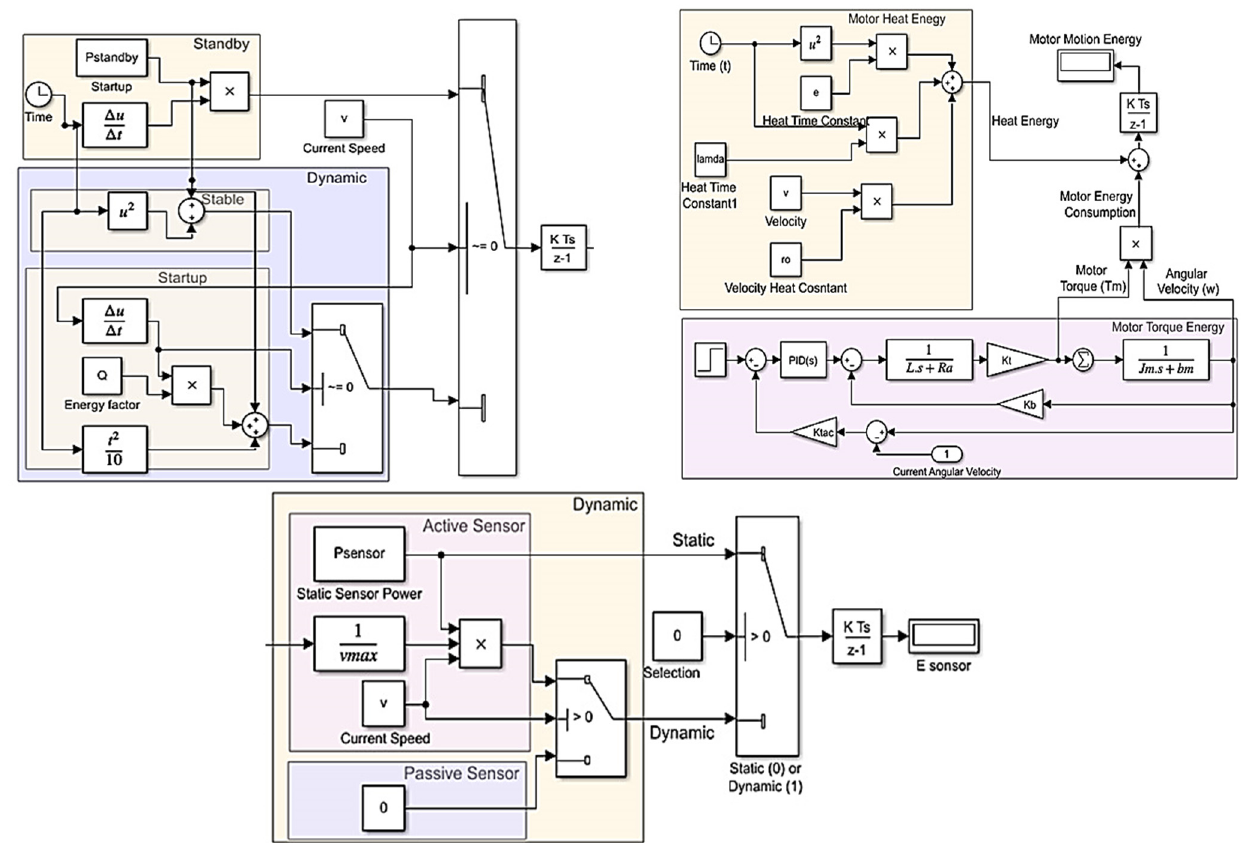
Figure 4. Energy consumption SIMULINK Model.